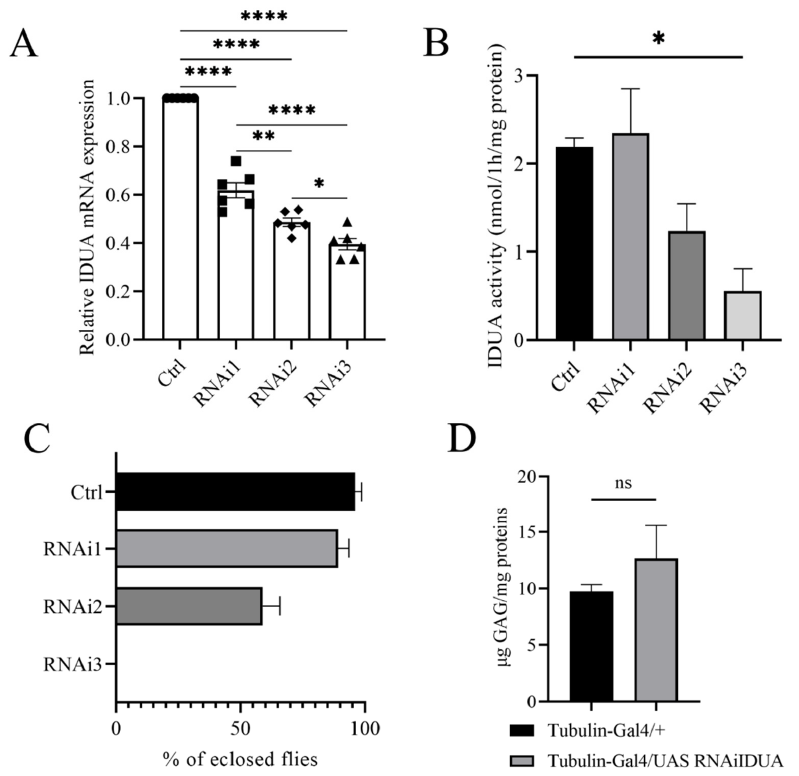
Figure 2. Characterization of the D-idua RNAi lines. ( A ) qRT-PCR on third instar larvae down-regulated for the D-idua gene with the driver Tubulin-Gal4 (one-way ANOVA with Tukey’s post hoc test. * p < 0.05; ** p < 0.01; **** p < 0.0001). Data are the results of three different larvae extracts, each of them analyzed twice, in triplicate. ( B ) D-idua activity in III instar larvae when D-idua was ubiquitously down-regulated with the driver Tubulin-Gal4. Data are the result of three different larvae extracts, each of them analyzed twice, in duplicate. (two-tailed Student’s t -test * p < 0.05) ( C ) % of eclosed flies when D-idua was down-regulated with the driver Tubulin-Gal4 in the three different UAS IDUA strains. ( D ) GAG analysis in III instar larvae when D-idua was ubiquitously down-regulated with the driver Tubulin-Gal4. Data are the result of three different larvae extracts, each of them analyzed twice, in duplicate (two-tailed Student’s t -test). All data are expressed as means ± SEM. Asterisks indicate a statistically significant